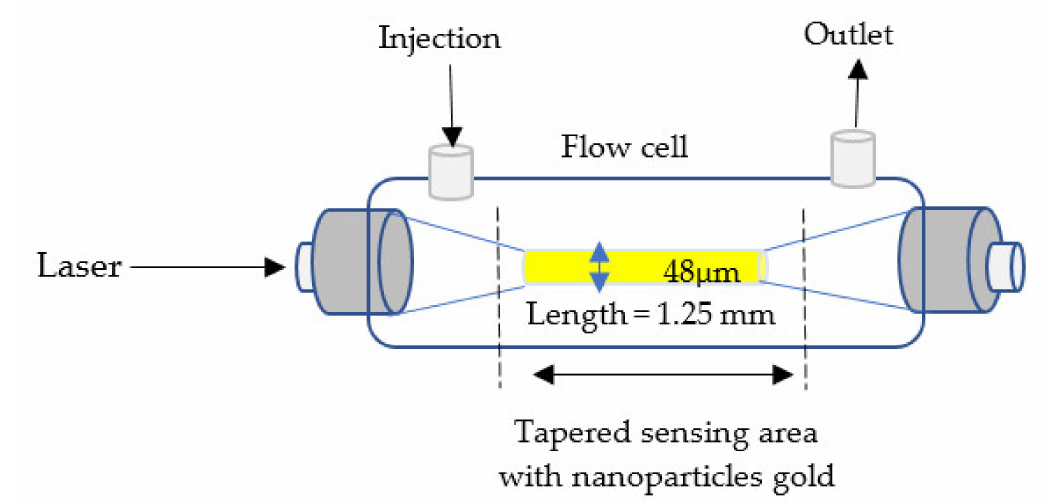
Figure 7. Tapered fiber optic based on surface plasmonic resonance (SPR) [105].